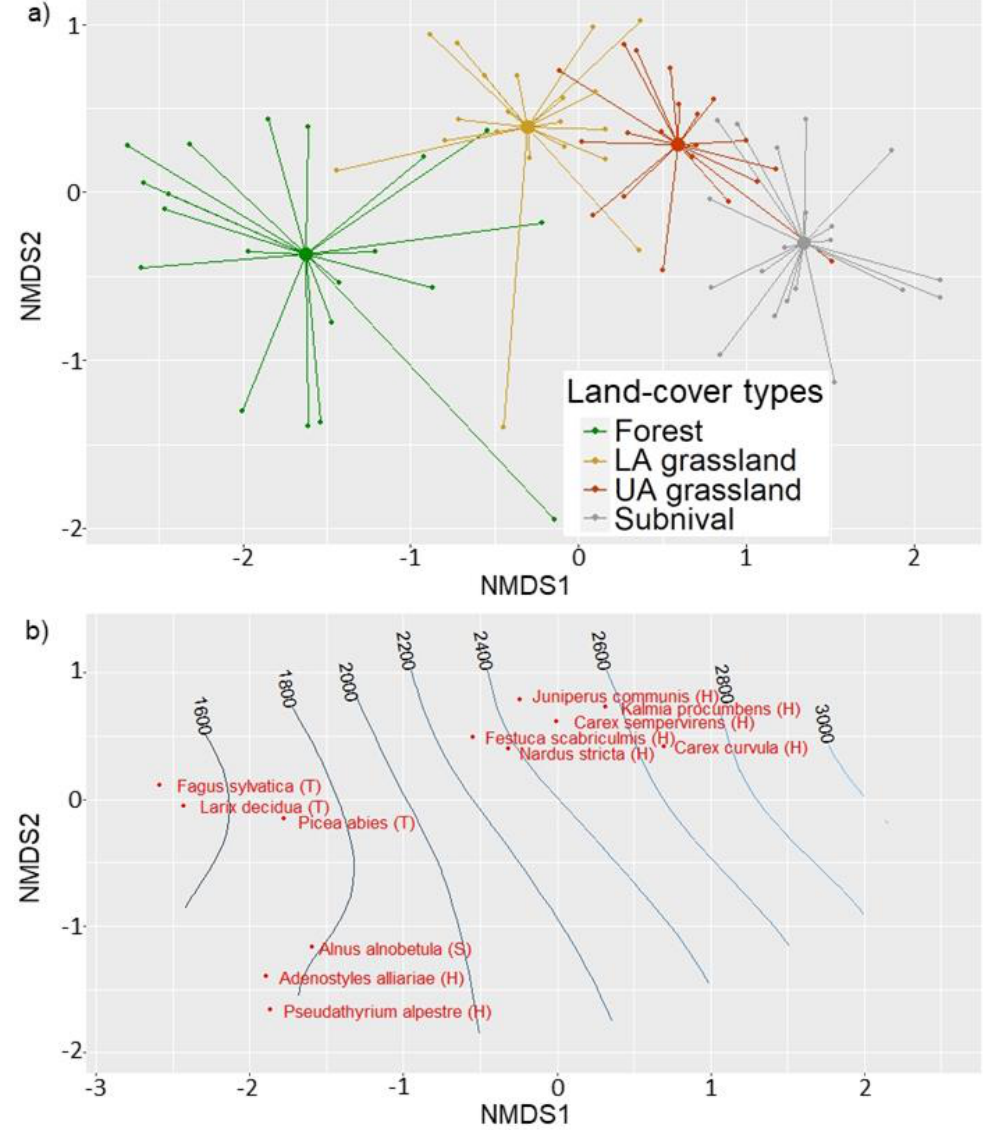
Figure 2. The Non-Metric Multidimensional Scaling (NMDS) bi-plots of the 80 vegetation plots sampled for the four vegetation belts. ( a ) A spider plot of the samples grouped according land-cover types and ( b ) a bi-plot with the main occurrence of dominant species and the corresponding elevation gradient are shown. Dominant species were defined as those with a cover higher than 35% for more than the 5% of samples within vegetation type. Species layers are shown in brackets–i.e., T for tree, S for shrub, and H for herb layers.